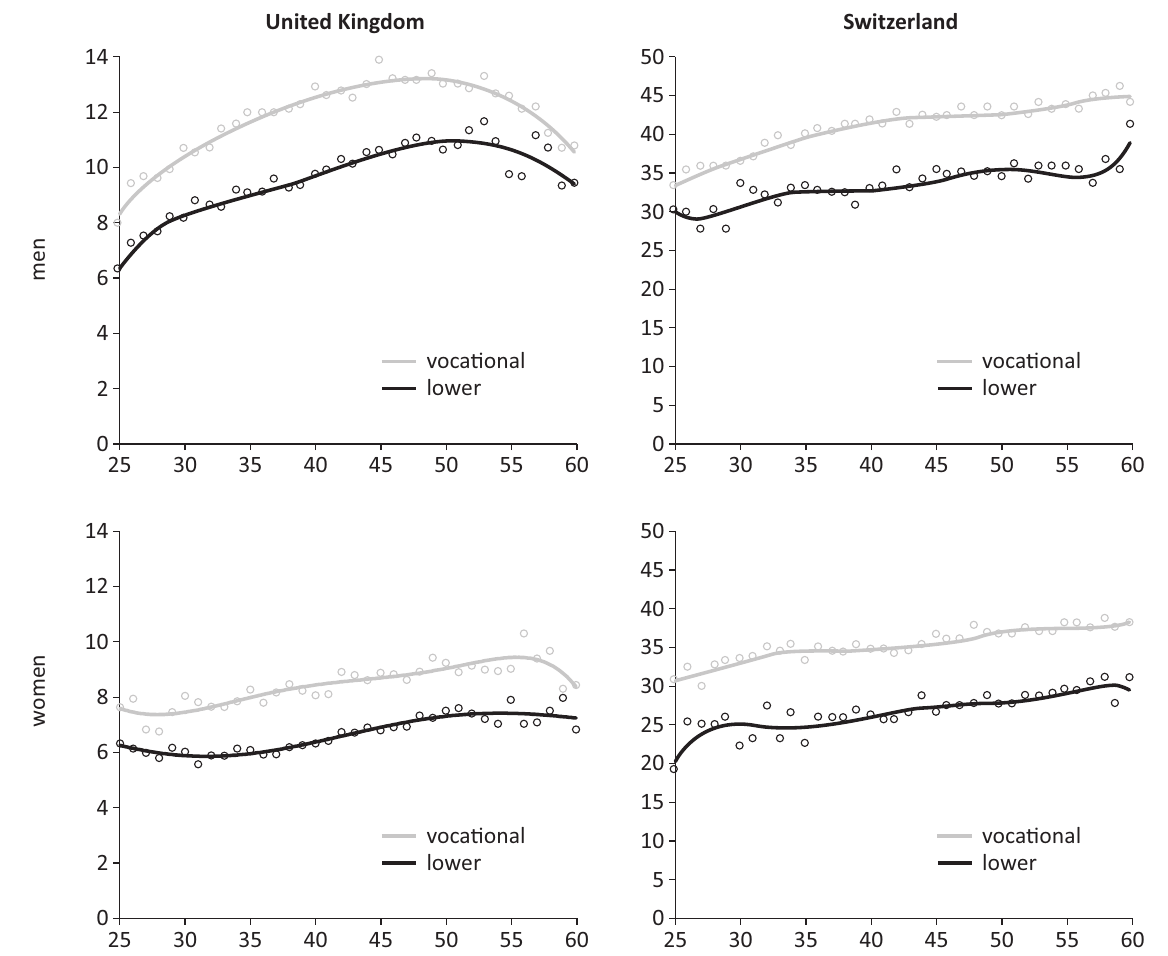
Figure 3. Median hourly wage (£/hour for UK, CHF/hour for Switzerland) for men and women by level of education: upper- secondary vocational education (vocational) and compulsory school level or lower (lower). Source: UK Labour Force Survey 1993–2014 and Swiss Labour Force Survey 1991–2014, cohort 1954–1968. Notes: Black and grey lines represent the poly- nomial trend line for the respective groups. Median hourly wage for the cohort 1954–1968: UK £13, CH